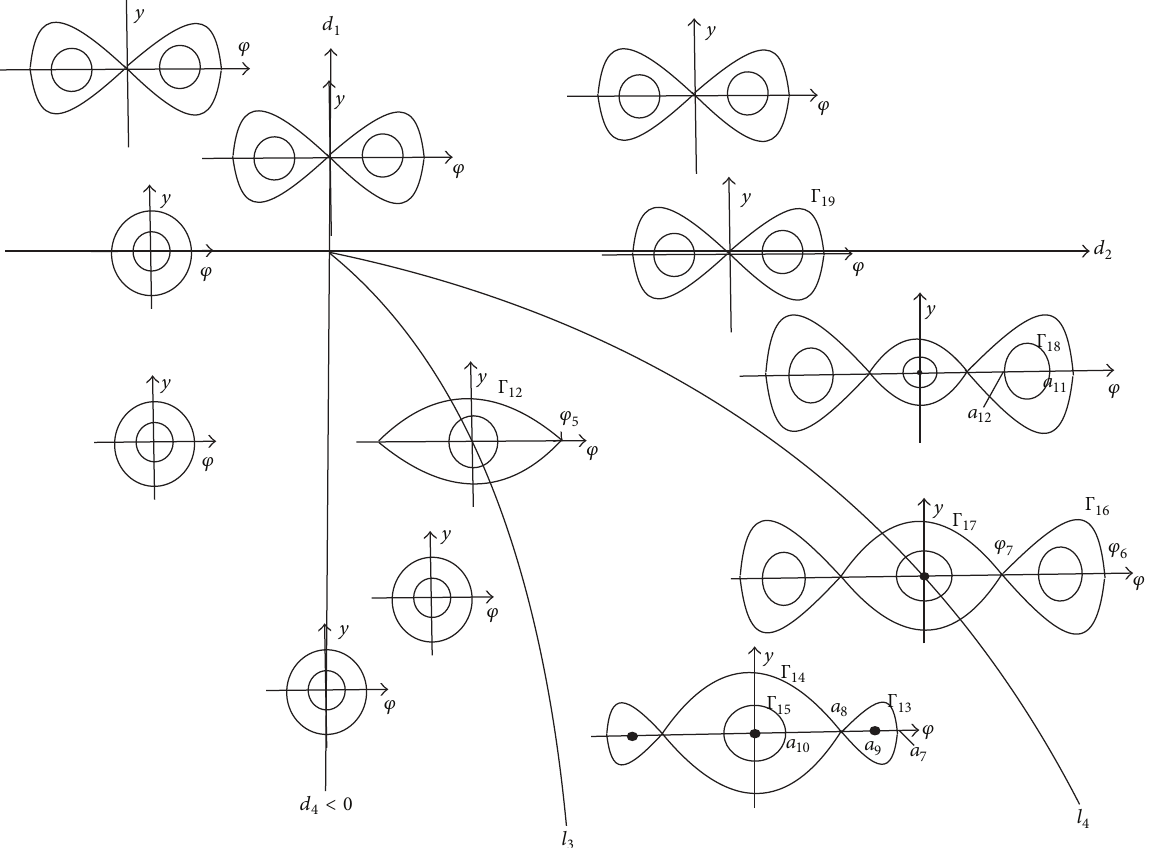
Figure 2: The phase portraits of system (12) when 𝑑 4 < 0